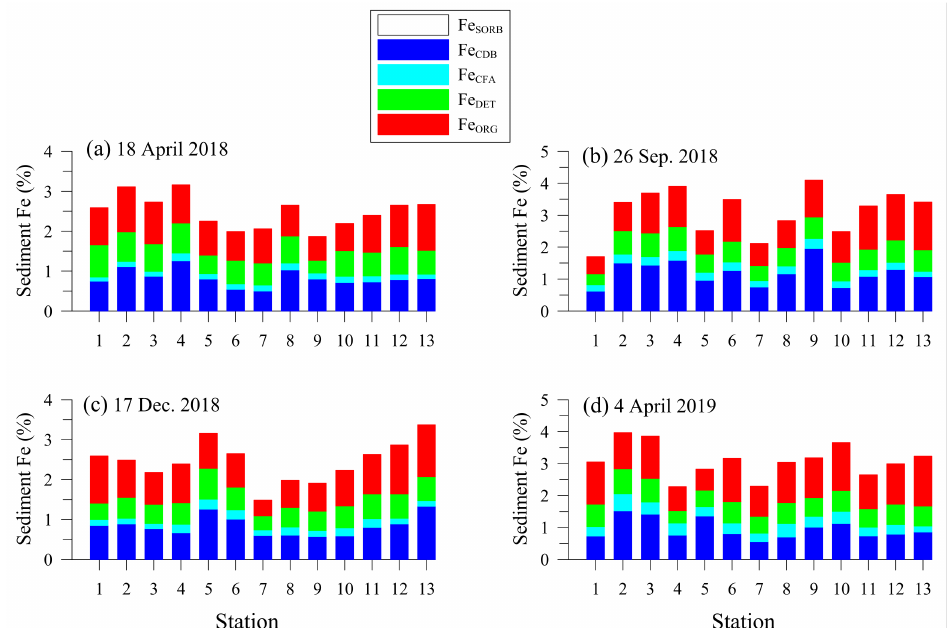
Figure 8. Seasonal distributions of the five Fe concentration fractions in the DRE surface sediments during the different surveys ( a ) 18 April 2018, ( b ) 26 September 2018, ( c ) 17 December 2018, and ( d ) 4 April 2019.